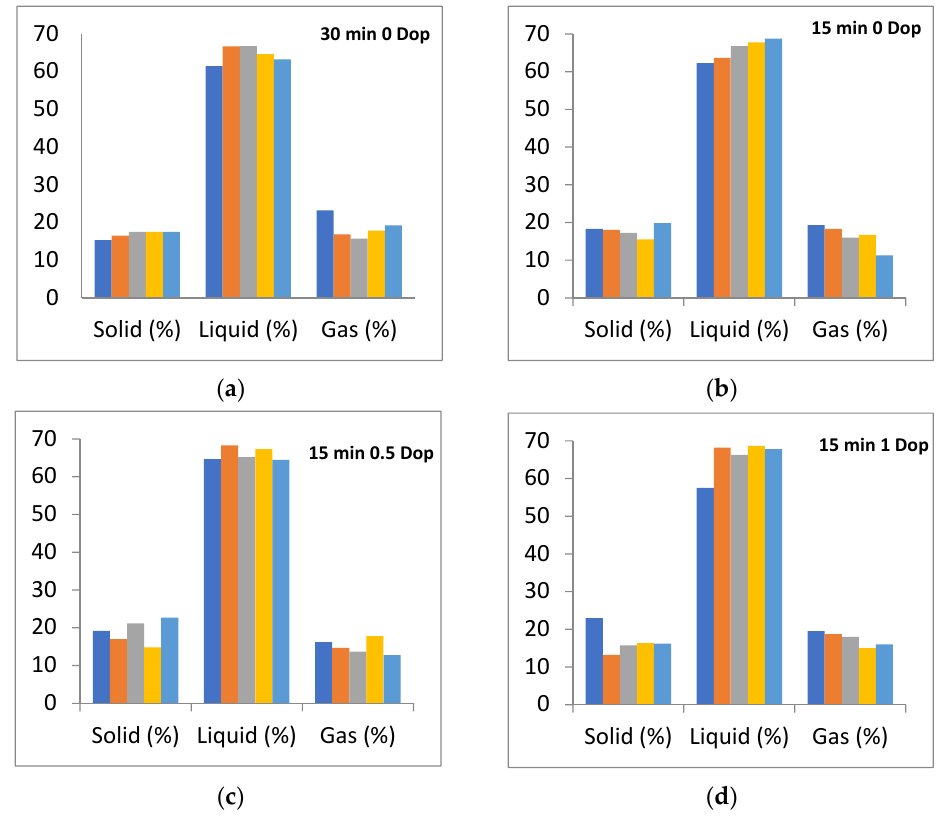
Figure 5. Comparative mass balance for the pyrolysis of waste leather tanned with chromium salts: ( a ) 30 min 0 g Dop; ( b ) 15 min 0 g Dop; ( c ) 15 min 0.5 g Dop; ( d ) 15 min 1 g Dop.